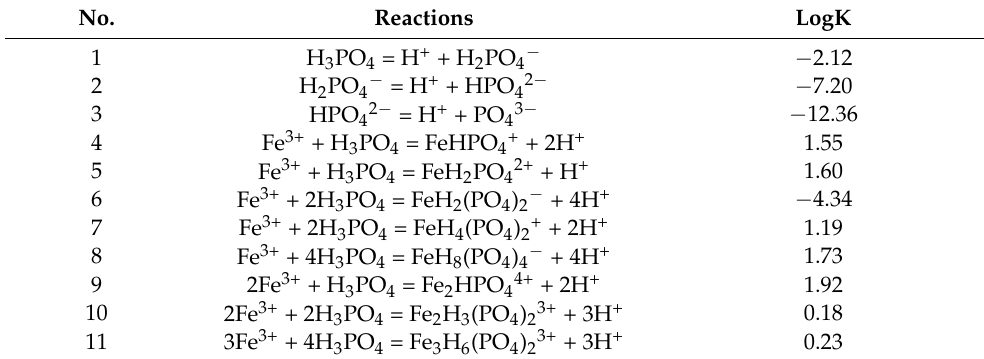
Table 3. Possible complexation reactions for Fe 3+ and phosphate. No.